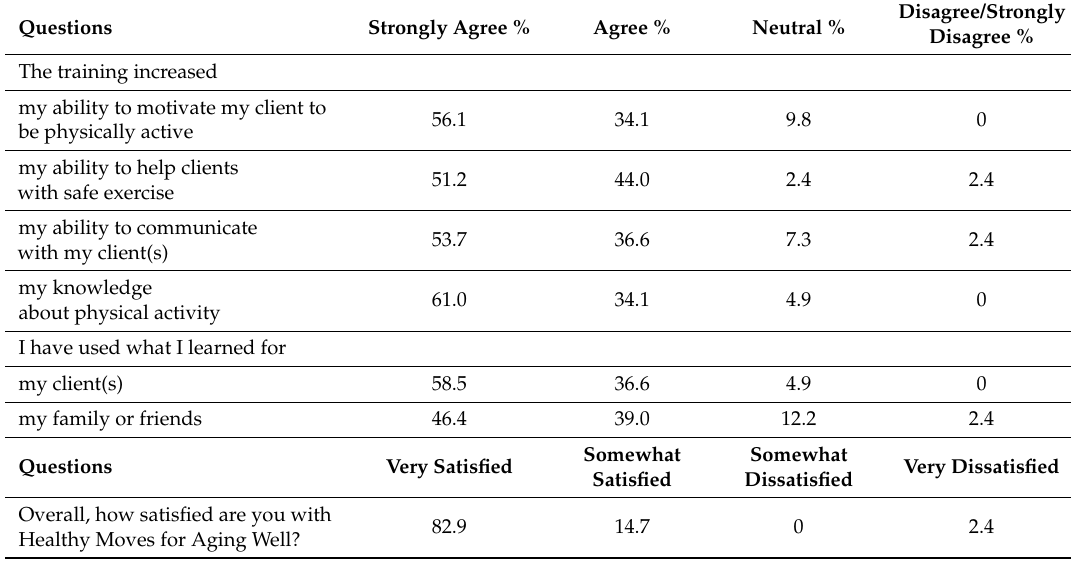
Table 3. Home care aides’ evaluation of Healthy Moves program ( N =